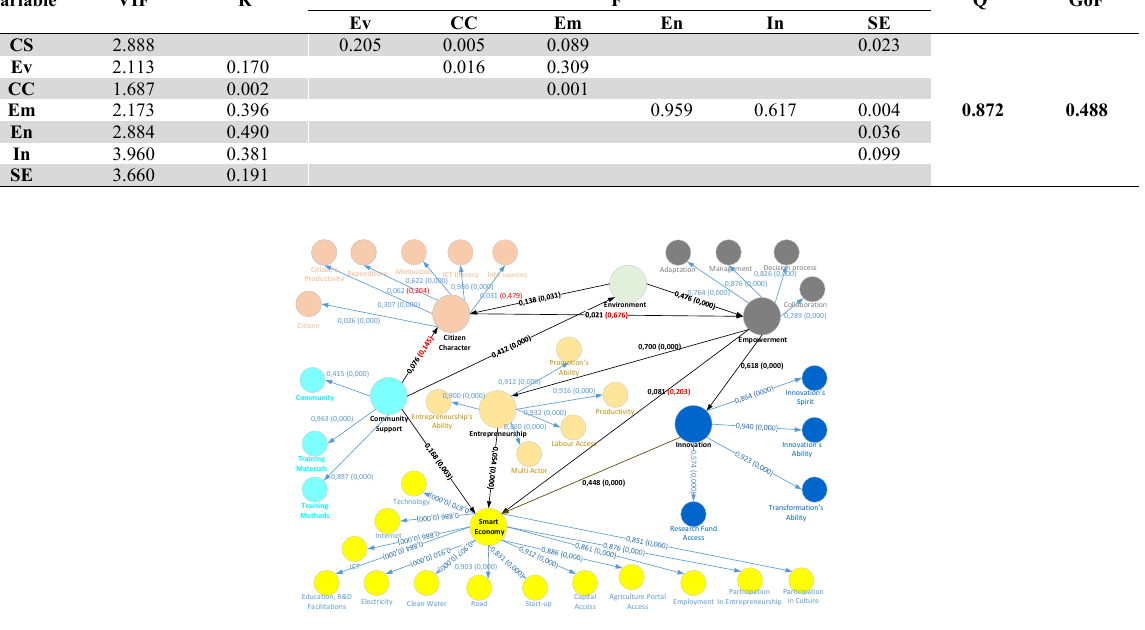
Fig. 5. The value of the contribution of the dimensions and latent variables of the citizen science model for the smart econ- omy (corresponding significances p <